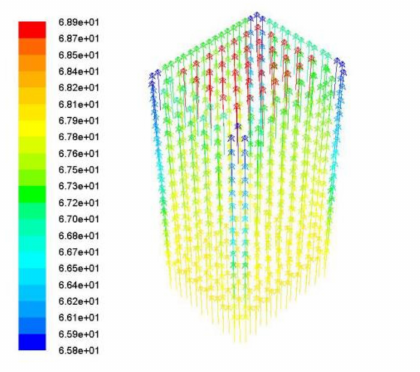
Figure 4. Simulation of 2.15 × 10 2 × 1.8 × 10 2 mm airduct.